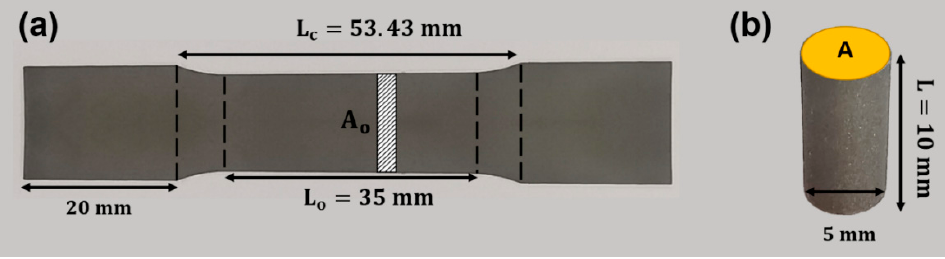
Figure 3. Dimensions of additively manufactured Ti6Al4V ( a ) tension dogbone sample ( b ) compres- sion bulk sample.